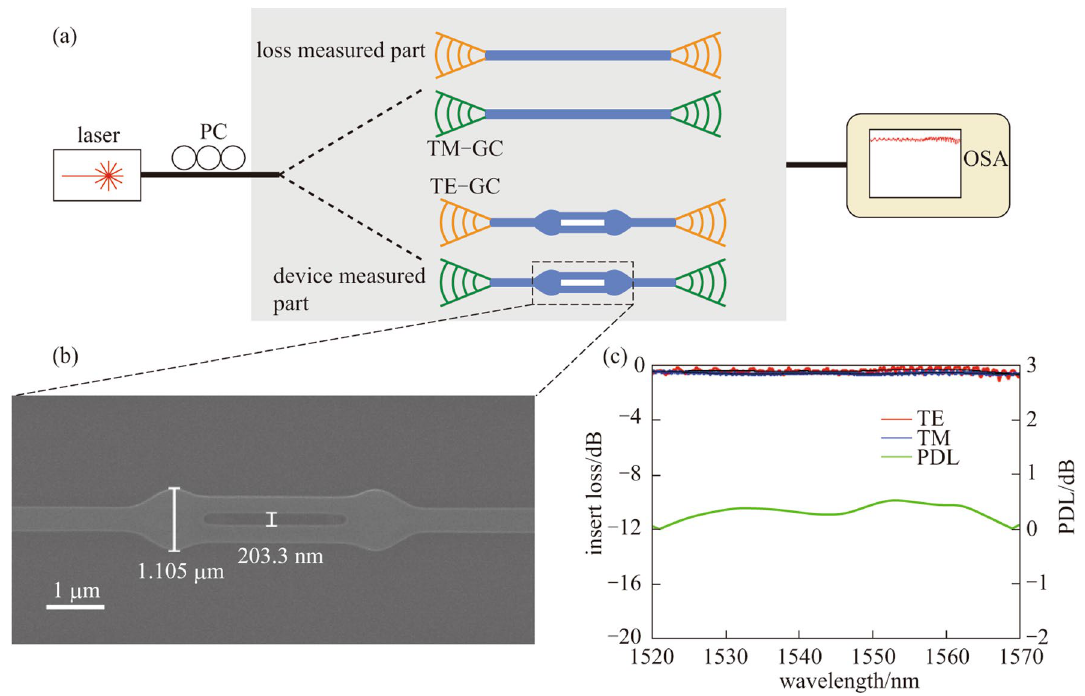
Fig. 3 a Schematic of the device measurement. PC, polarization control; TM-GC, TM polarization sensitive grating coupler; TE-GC, TE polari- zation sensitive grating coupler; OSA, optical spectrum analyzer. b Top-view SEM picture of fabricated converters. c Measured transmission of TE0 mode (red line) and TM0 mode (blue line); the black line are trend lines by robust locally weight regression method. The green line repre- sents the polarization dependent loss